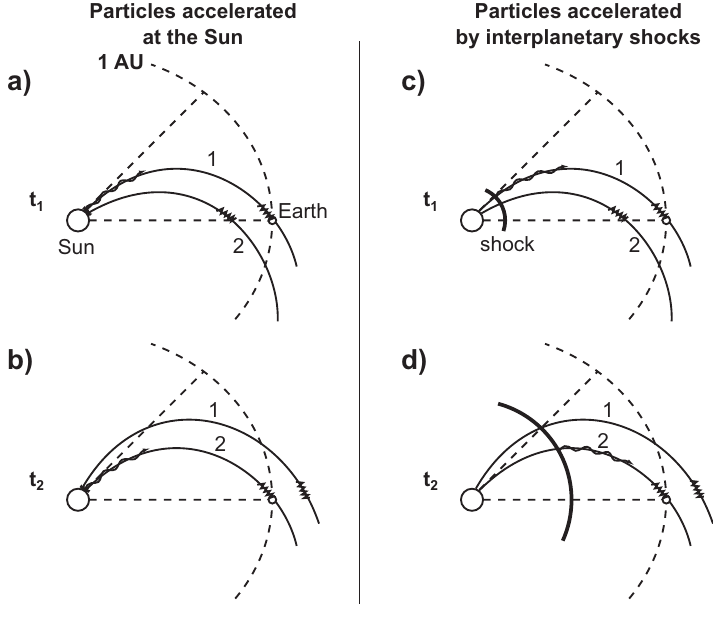
Fig. 1. The combined motion of ra- dial expansion and corotation with the Sun causes the interplanetary field lines to continuously sweep past the Earth. Two magnetic field lines with Parker spiral configuration are illustrated in the panels of the figure. The dashed por- tion of the second field line is the part that is sampled at Earth in 1 day. En- ergetic particles (cyclical motion sym- bols) follow the magnetic field lines which corotate with the Sun. The fos- sil plasma waves (sawtooth symbols), however, are convected radially out-